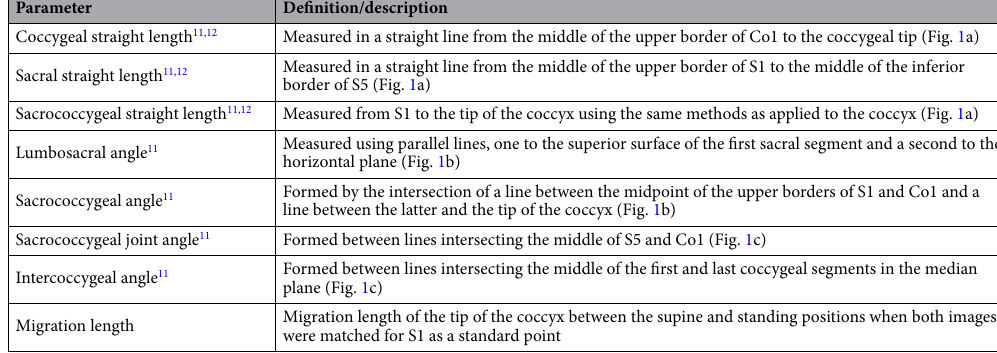
Table 1. Definitions/descriptions of parameters of the morphology and morphometry of the